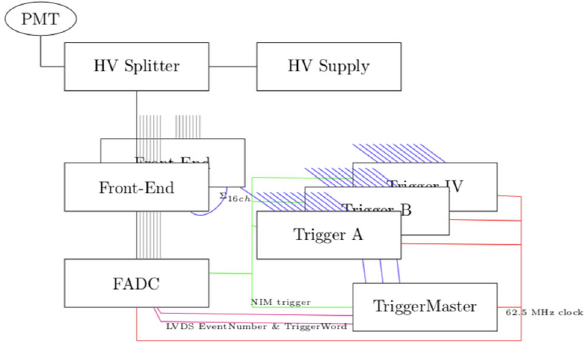
Fig. 22 Double Chooz simplified electronics